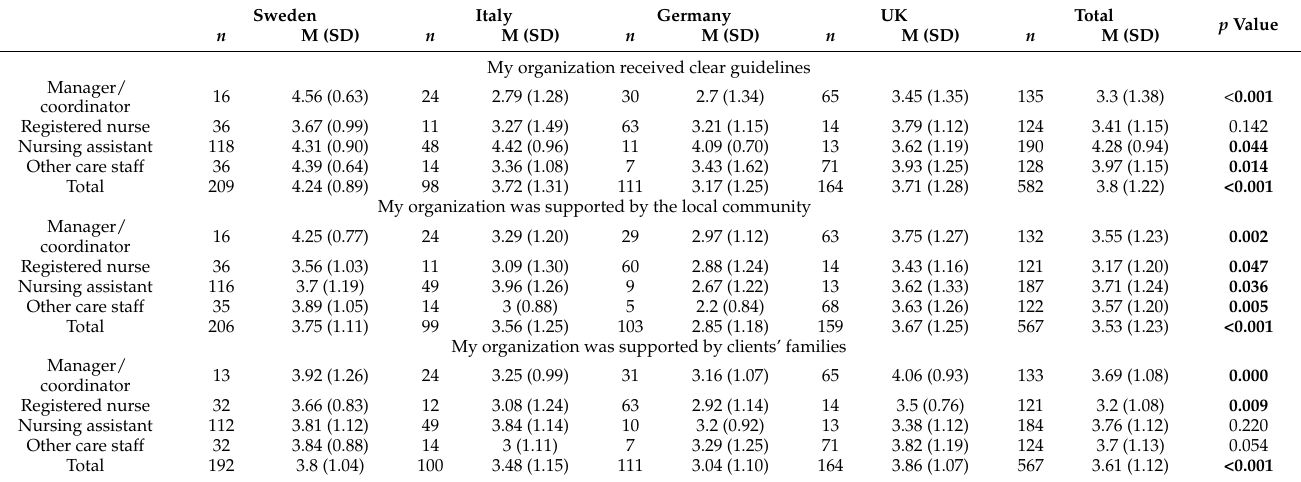
Table 4. External support for the organization by profession and country.